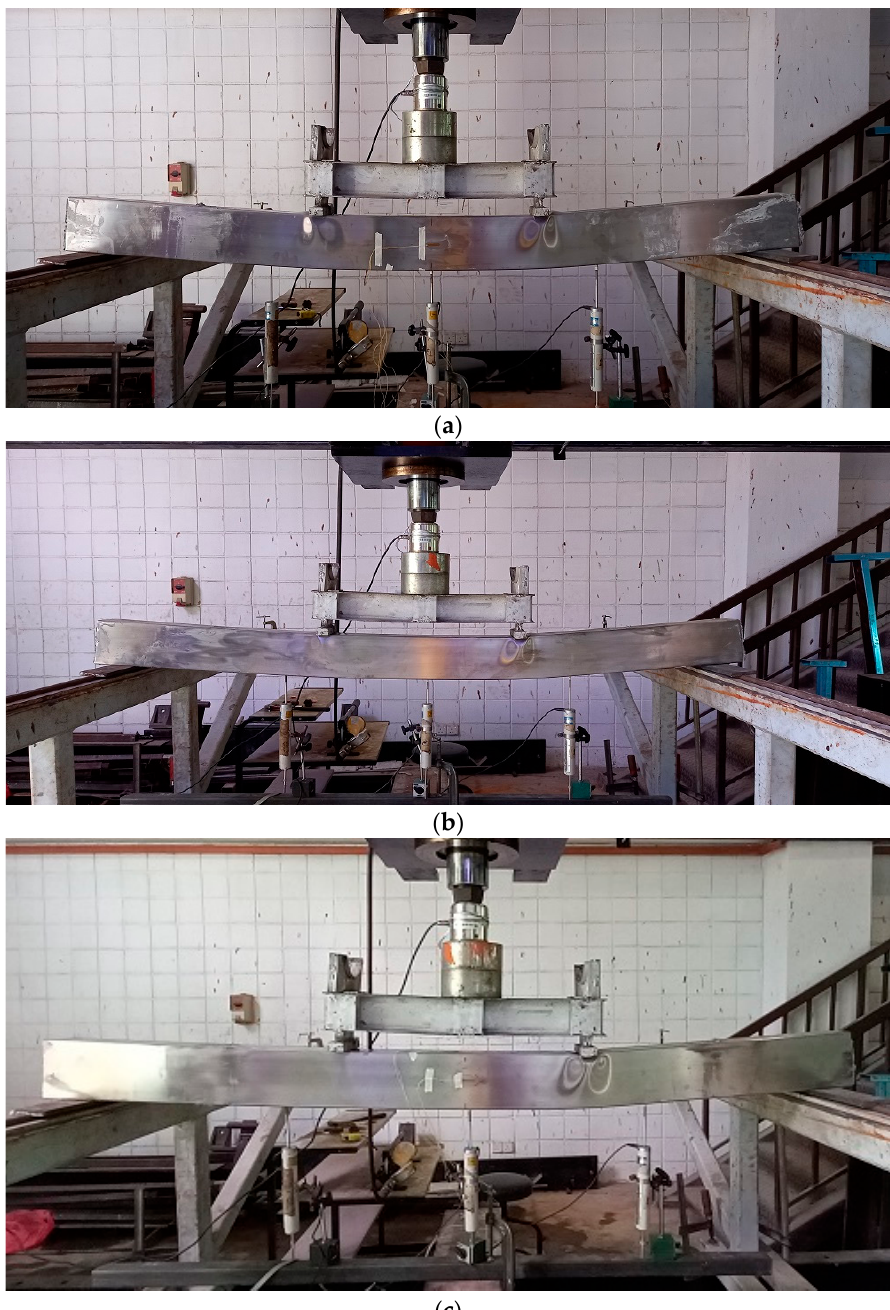
Figure 4. Typical fl exural behavior of the specimens with/without recycled aggregates. ( a ) Speci- men MC0; ( b ) specimen MC50; and ( c ) specimen